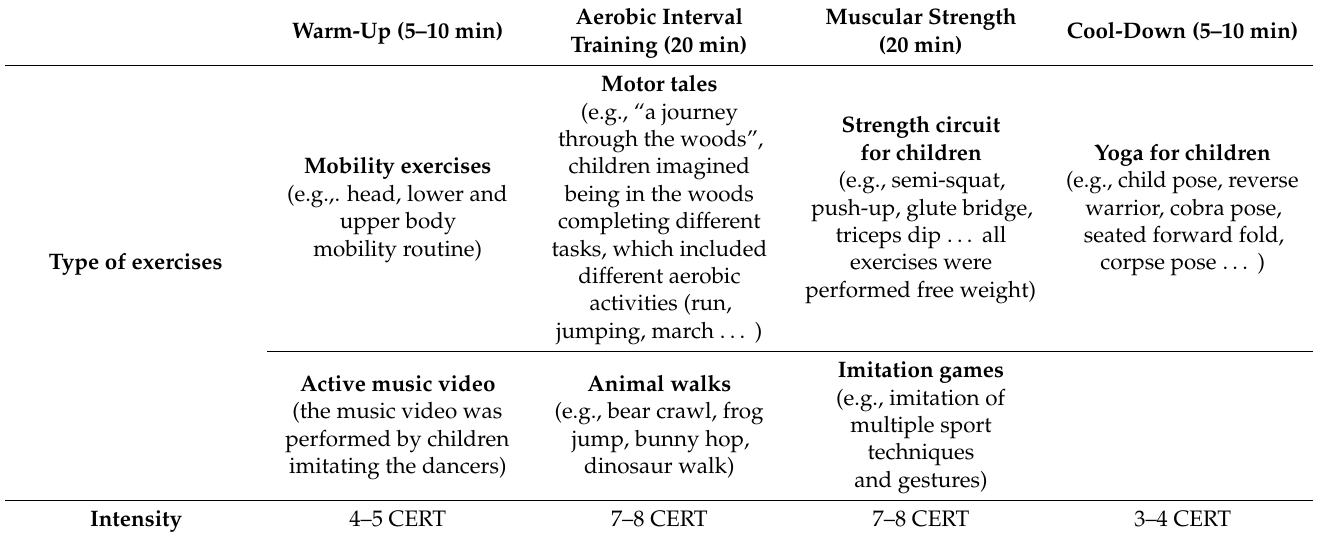
Table 1. Example of a typical training session.